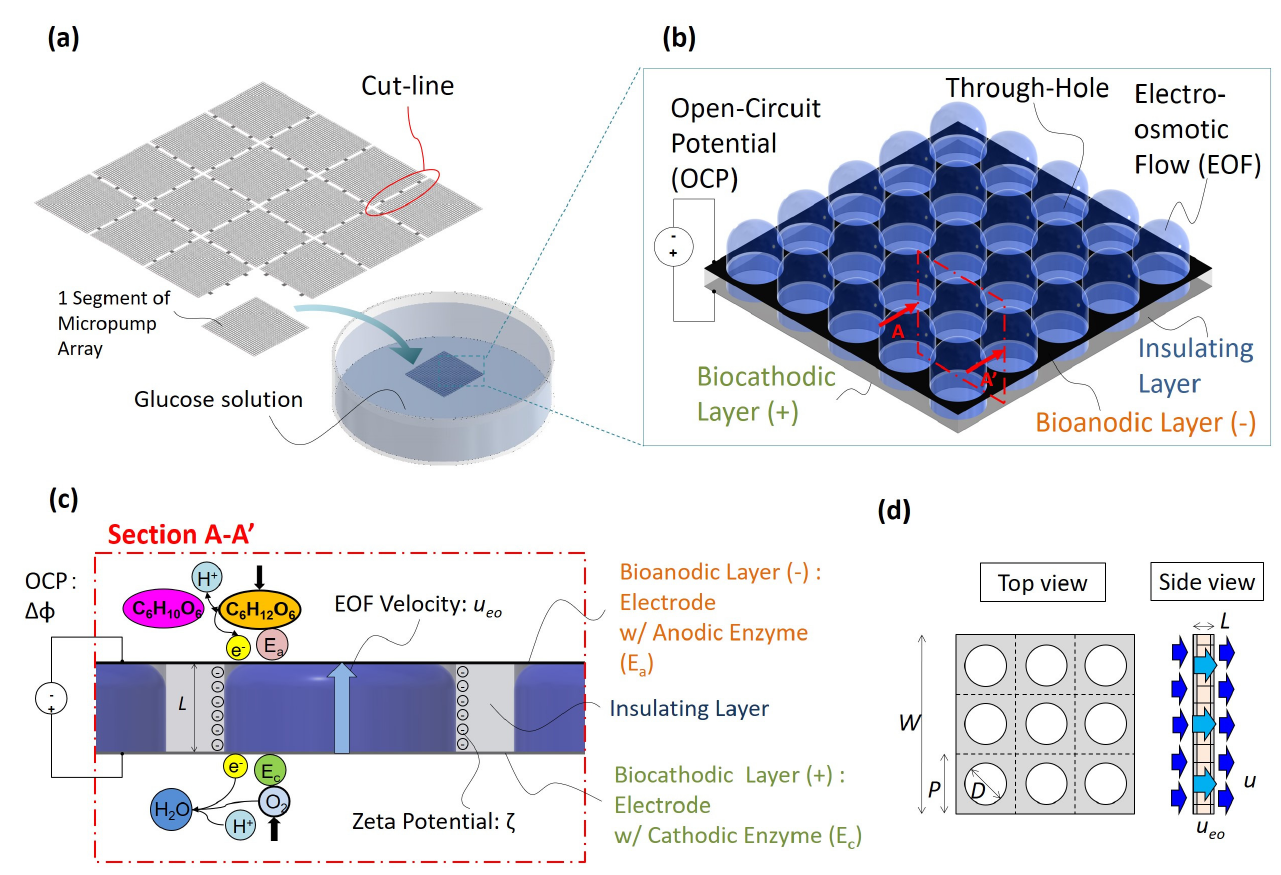
Figure 2. Concept of a film-shaped micropump array. ( a ) Size-adjustable configuration consisting of multiple segments and cut-lines. ( b ) Minimal configuration. ( c ) BFC and EOF mechanisms with related parameters. ( d ) Other design